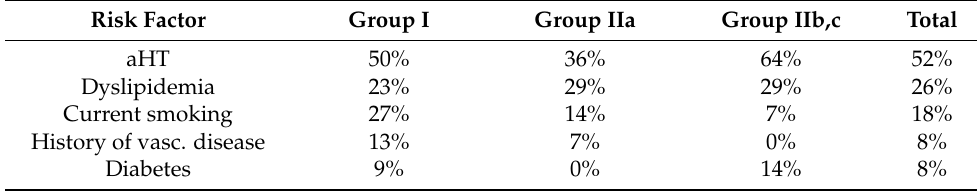
Table 1. Prevalence of CAD risk factors in studies’